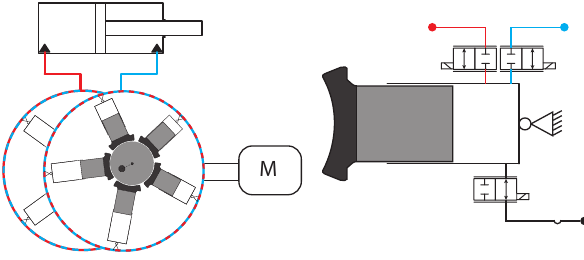
Figure 18: Conceptional drawing of a digital hy- draulic direct cylinder drive with multiple inlets/outlets.